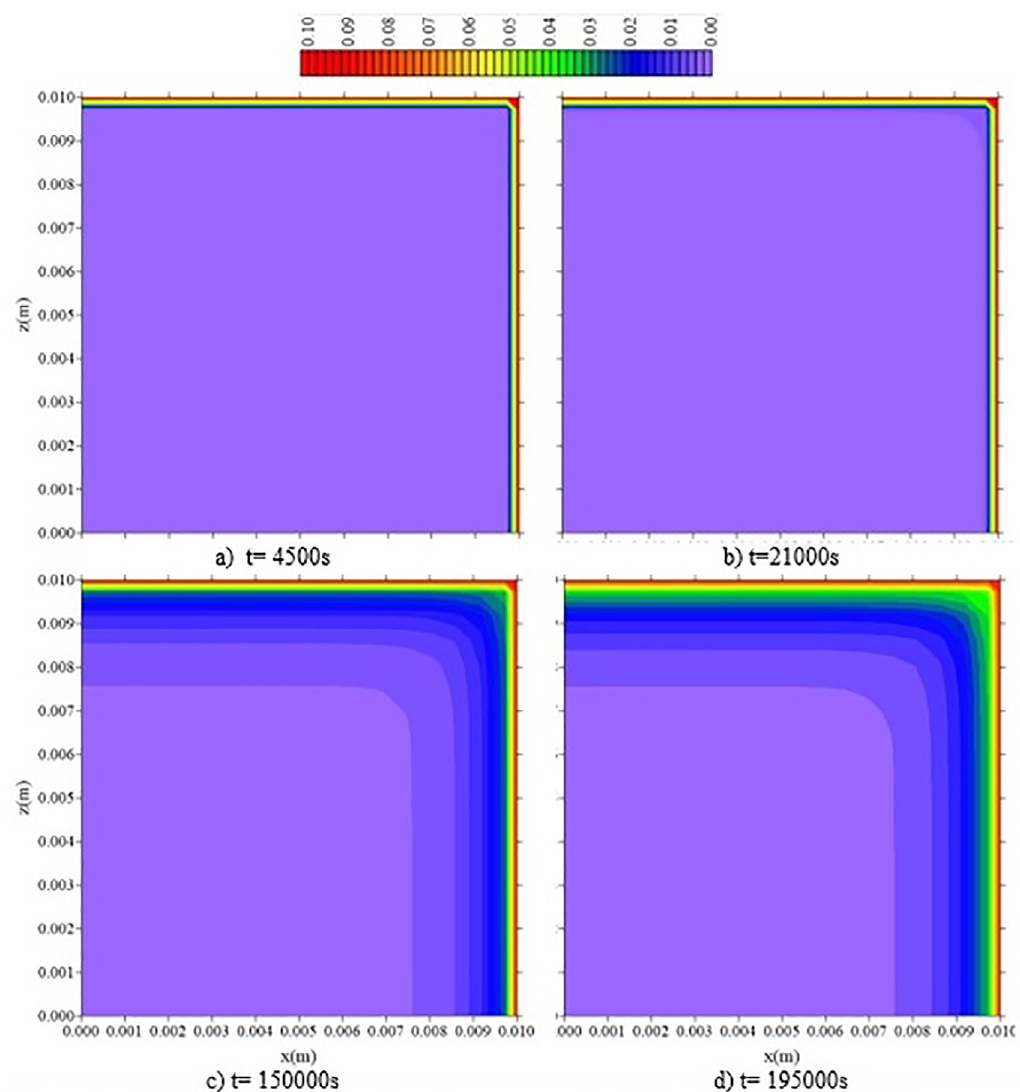
/2 plane for different water absorption y